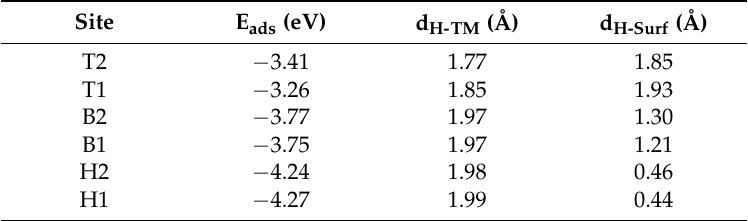
Table 2. Calculated adsorption energy ( E ads ), average distance between H atom and metal atom ( d H-TM ) as well as average distance between H atom and the top layer ( d H-Surf ) in slab model of Mo-doped Nb (100) surface for adsorbed hydrogen atoms at different sites indicated in Figure 4